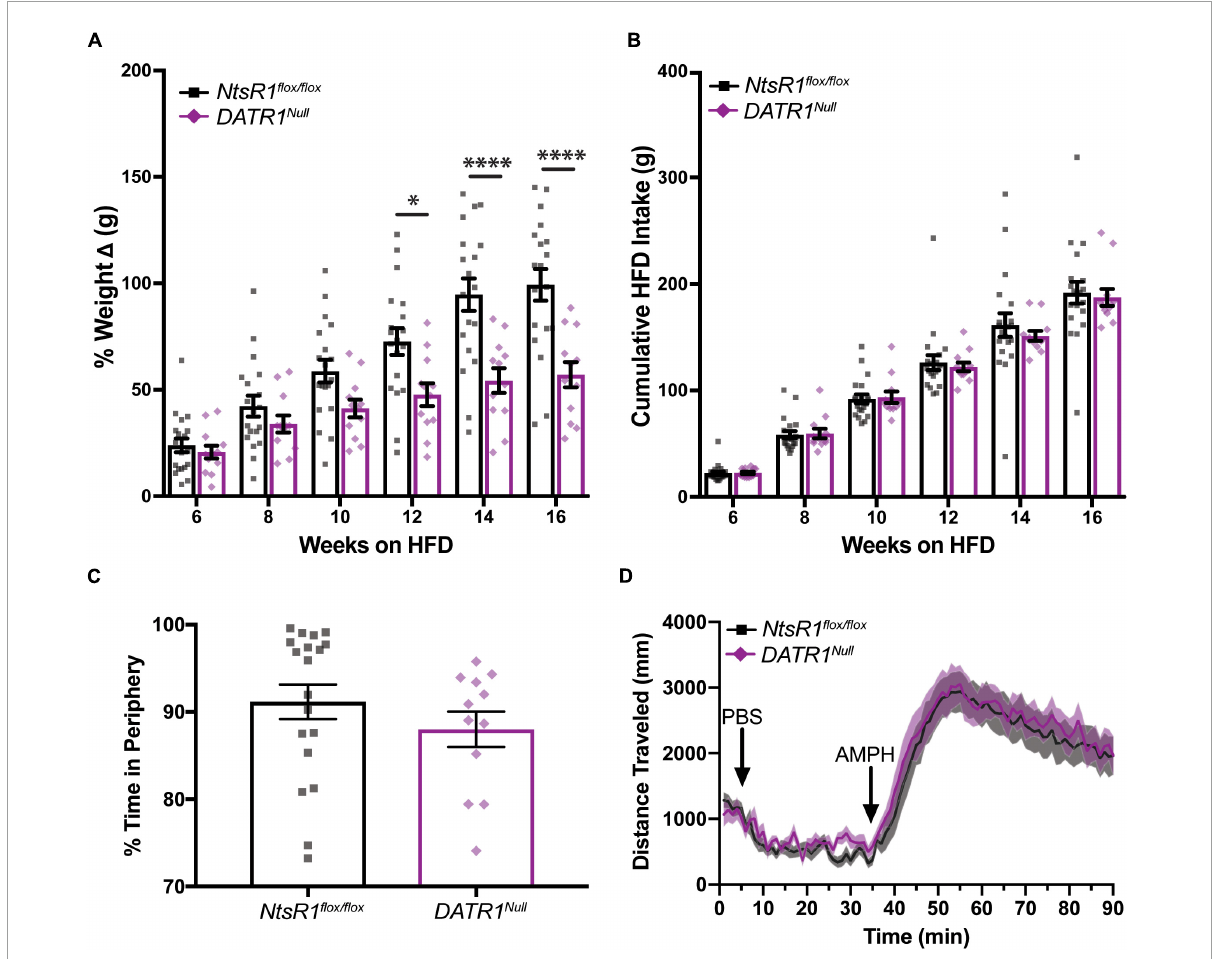
FIGURE5 Developmental deletion of NtsR1 partially protects mice from diet-induced obesity. (A,B) HFD fed NtsR1 flox / flox and DATR1 Null mice were individually housed and analyzed in home cages. Body and HFD weight was measured weekly. (A) % weight change every 2 weeks. HFD fed DATR1 Null have significantly lower weight compared to NtsR1 flox / flox mice on the same diet during weeks 12–16. (B) Cumulative HFD intake every 2 weeks. NtsR1 flox / flox and DATR1 Null mice consume similar amounts of HFD. Data represent mean ± SEM analyzed via Ordinary 2-Way-ANOVA with Sidak’s correction. (C) % time spent in open field box periphery (30 min). (D) Distance traveled before, during and after PBS and AMPH treatment, binned in 1 min intervals. Mice were left to explore the open field box for 30 min after PBS injection, and for 55 min after amphetamine (AMPH) treatment. n = 12–20. ∗ p < 0.05, ∗∗∗∗ p <